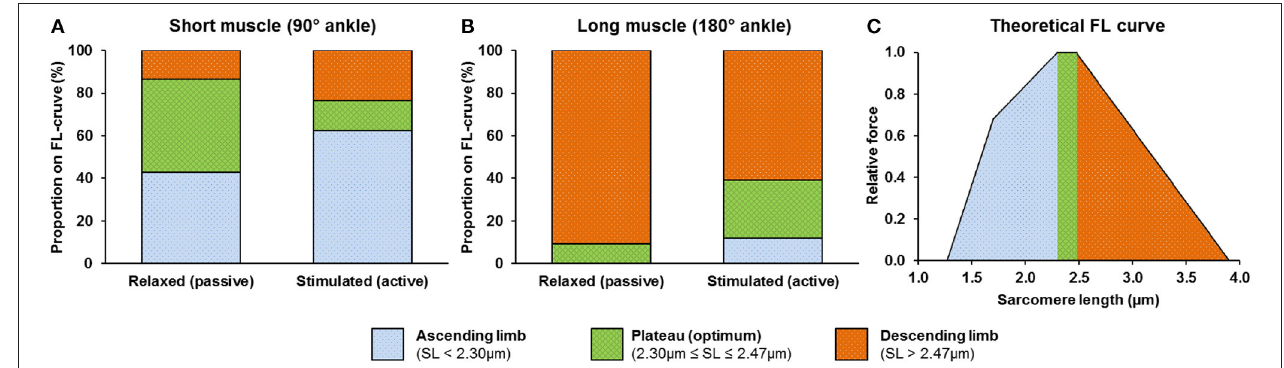
FIGURE 6 | Activation-induced changes in proportion of sarcomeres with lengths that fall onto the ascending limb, plateau region, and descending limb of the theoretical force-length (FL) curve at short (A) and long (B) muscle lengths. A theoretical FL curve of the mouse TA (Walker and Schrodt, 1974; Herzog et al., 1992; Gokhin et al., 2014) adapted from Gordon et al. (1966) is shown in (C) . For the relaxed-short muscle, 44% of the sarcomeres were located on the plateau region of the force-length relationship. For the relaxed-long muscle, 9% of the sarcomeres were located on the plateau region. In the active muscle, 14 and 27% of the sarcomeres were located on the plateau region for the short and long muscle length, respectively.